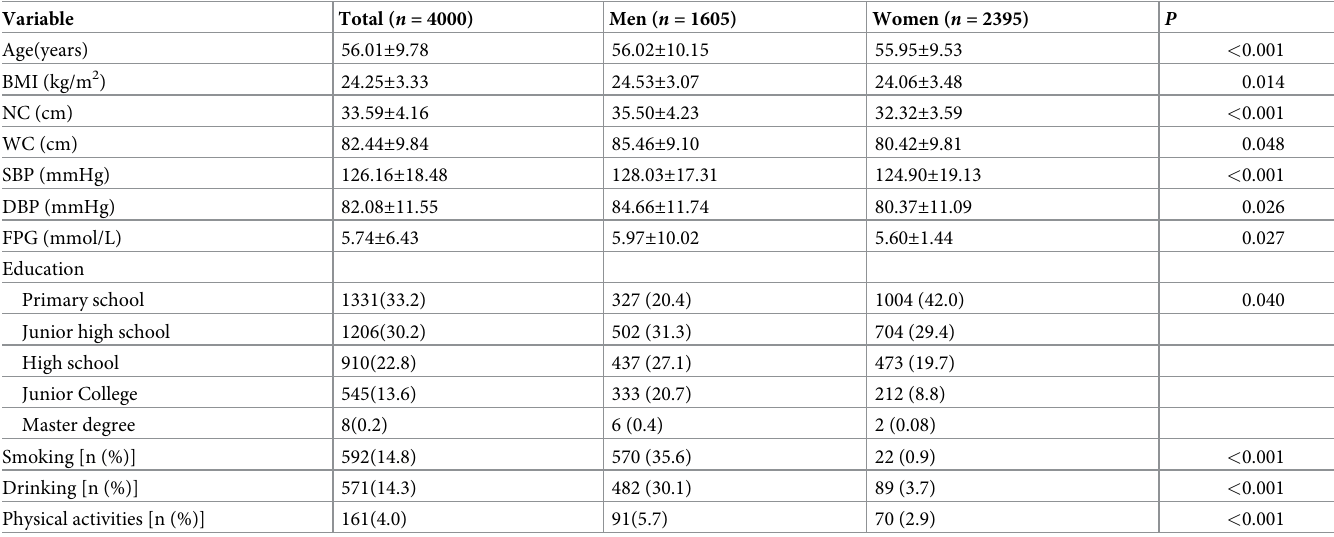
Table 1. Characteristics of the study participants stratified by gender. Variable